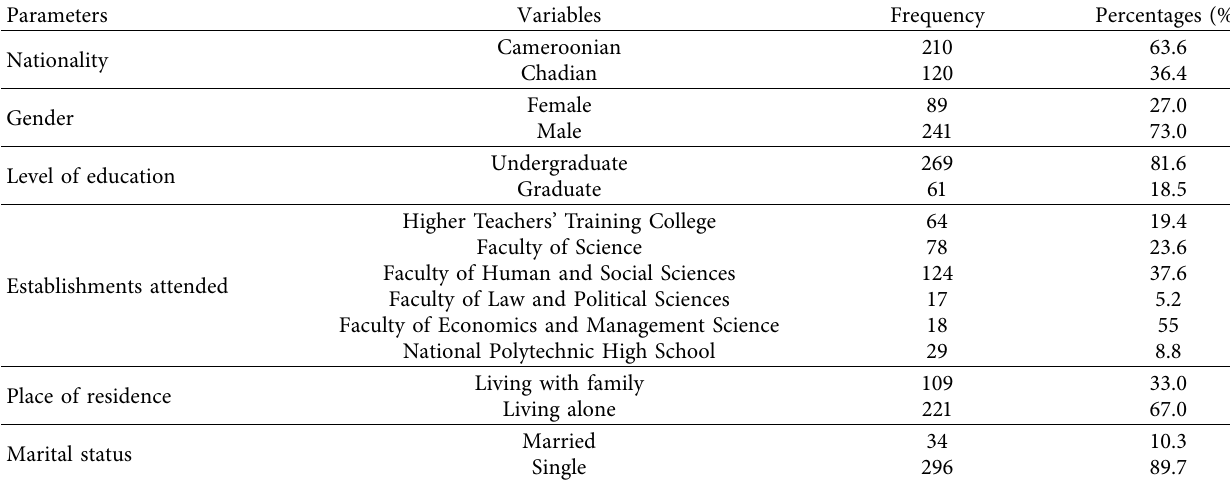
Table 3: Overall description of the study population.